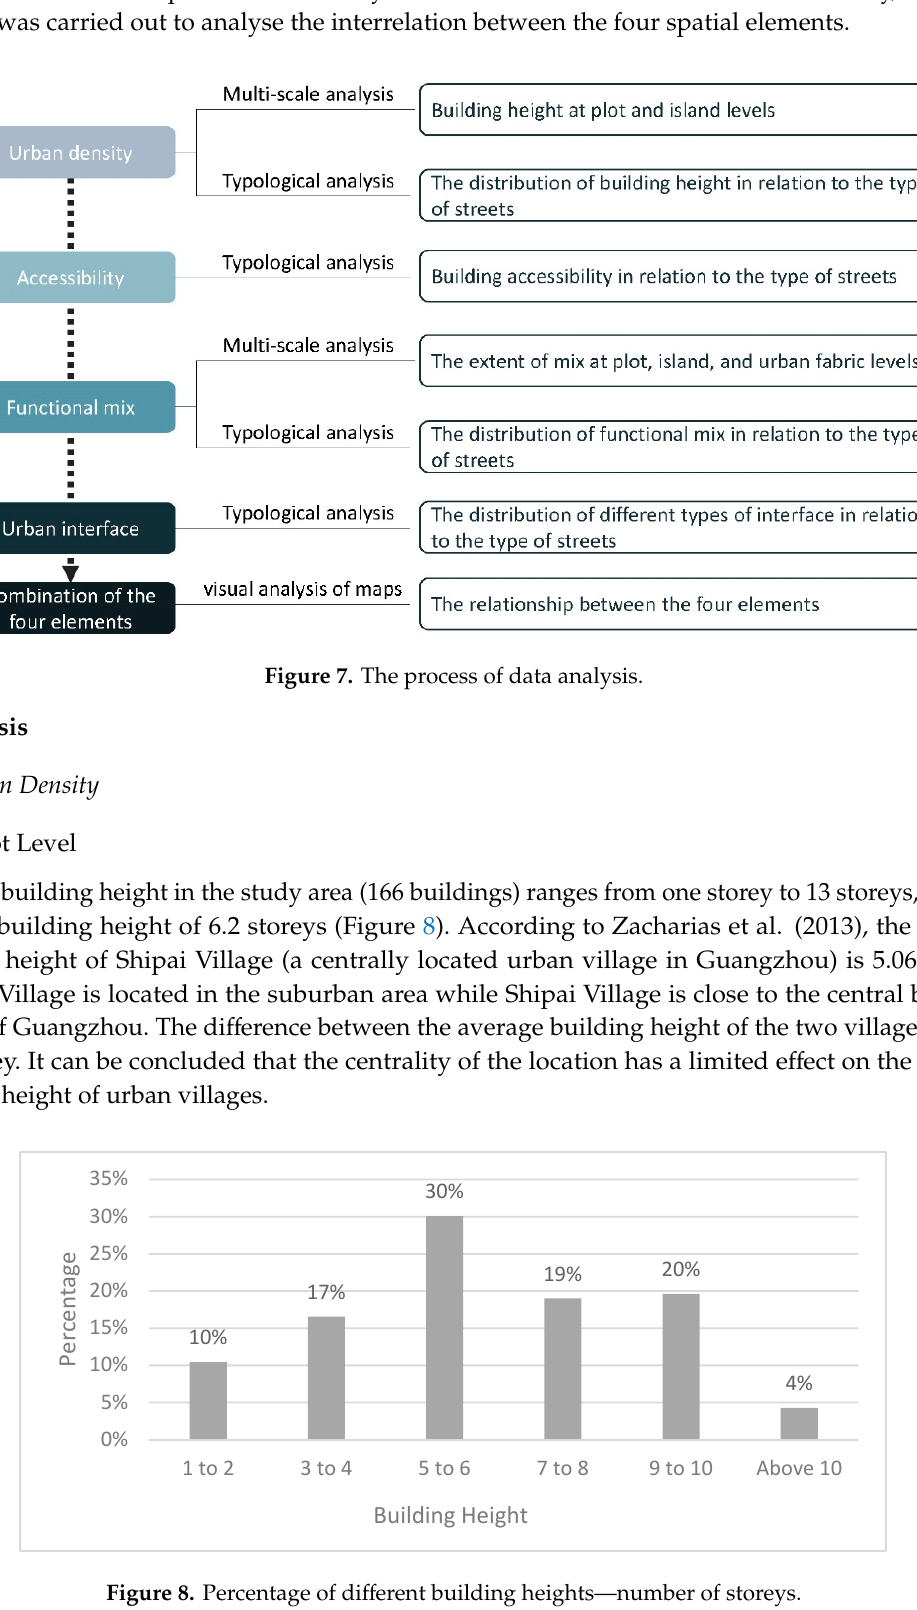
Figure 8. Percentage of different building heights—number of storeys.